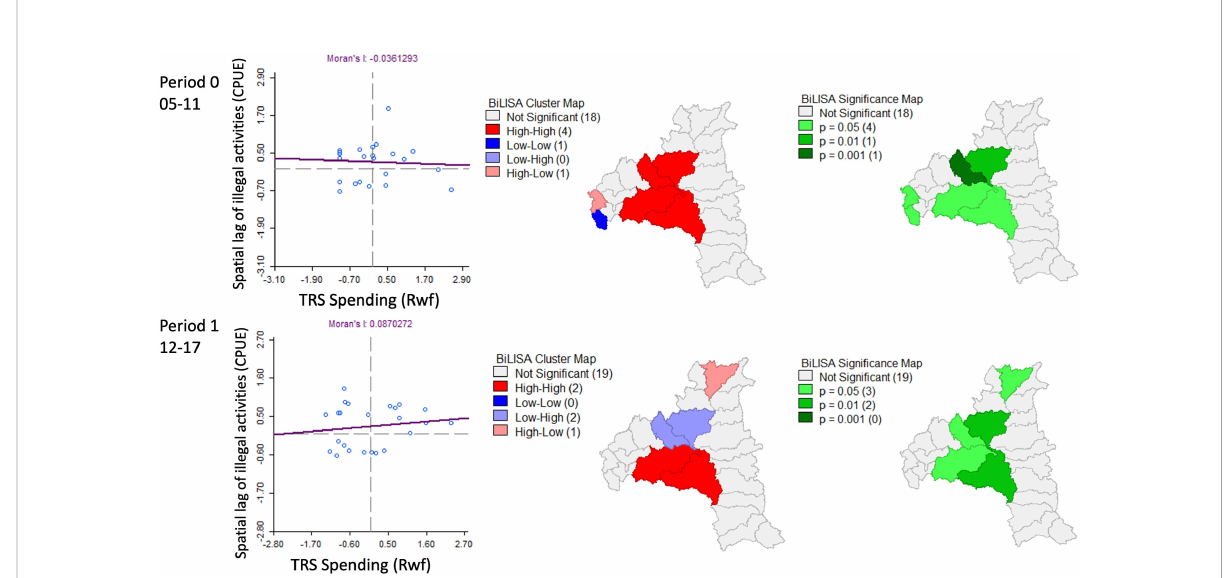
FIGURE 4 Bivariate local Moran ’ s I of TRS funding allocation relative to the spatial lag of illegal activities in sectors adjacent to Nyungwe National Park (essentially, the ‘ neighborhood ’ of illegal activities). The green signi fi cance maps show the level of statistical signi fi cance of these clusters. For both map types, numbers in parentheses (e.g., Not Signi fi cant (18) or High-High (2)) indicate the number of observations within that category. High-High: a sector of high TRS funding surrounded by sectors of high illegal activities; Low-Low: a sector of low TRS surrounded by sectors of low illegal activities; Low-High: a sector of low TRS surrounded by sectors of high illegal activities; High-Low: a sector of high TRS surrounded by sectors of low illegal activities. TRS, tourism revenue sharing; Rwf, Rwandan Franc/Franc